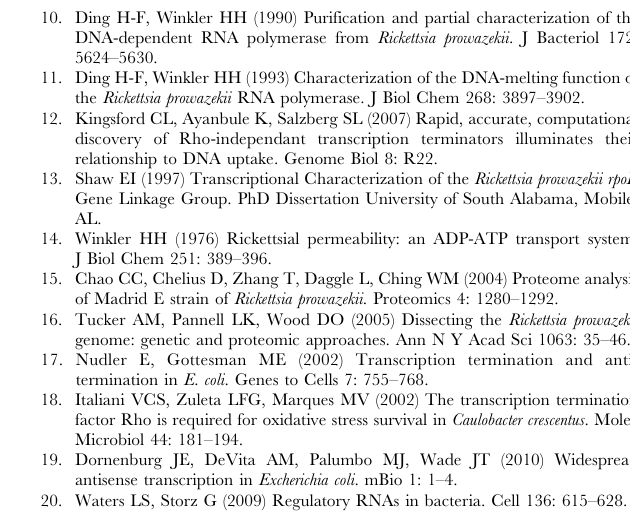
Table S1 Primer sequences used to generate RPA probes.